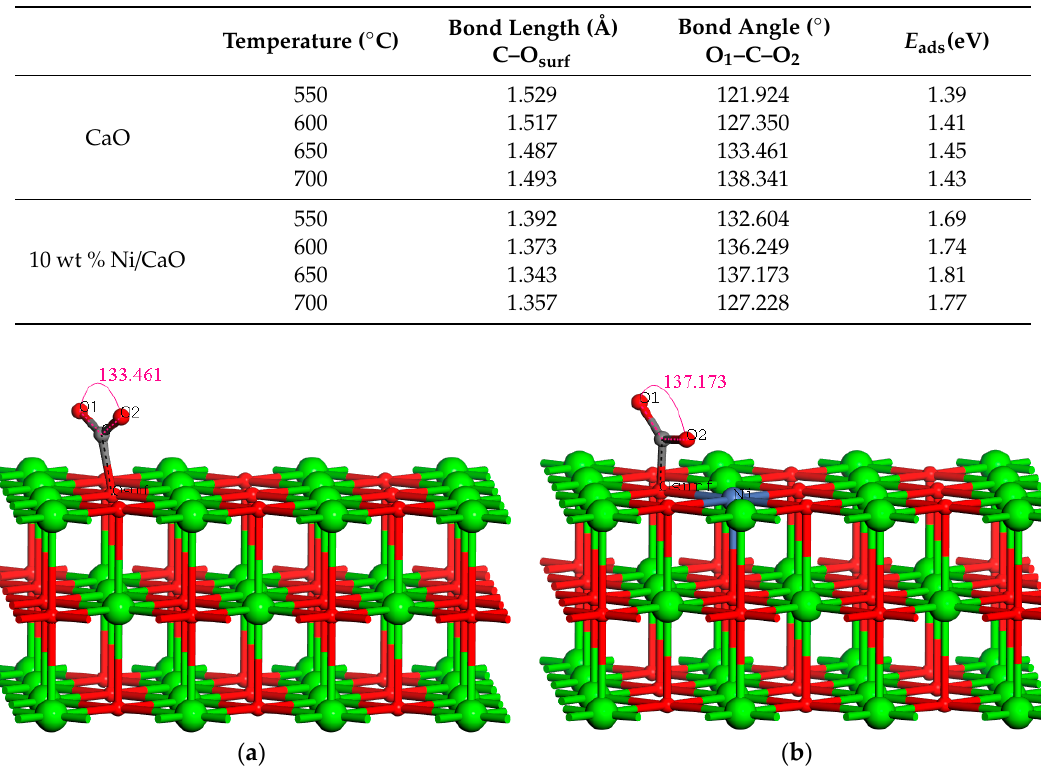
Figure 1. Adsorption configurations of CO 2 on the surfaces of CaO-based catalysts at 650 °C : ( a ) CO 2 adsorption on CaO (100) surface; ( b ) CO 2 adsorption on 10 wt % Ni / CaO (100) surface. Green, red, gray, and purple balls represent Ca, O, C, and Ni atoms.